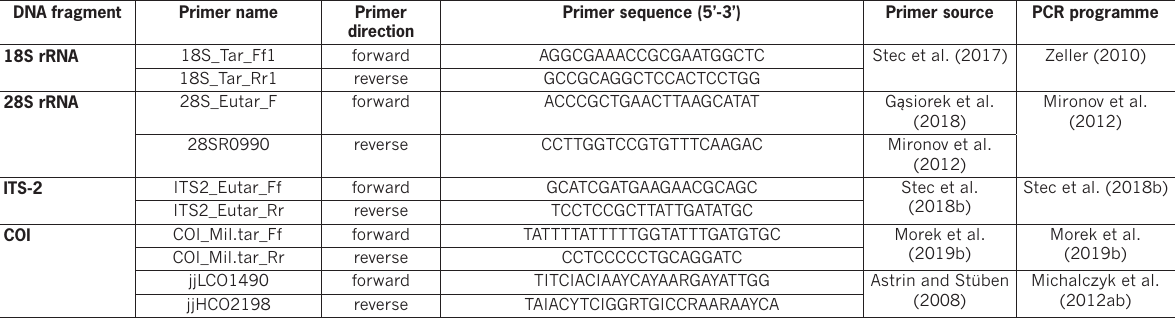
Table 2. PCR protocols and primers references for specific protocols for amplification of the four DNA fragments sequenced in the study. DNA